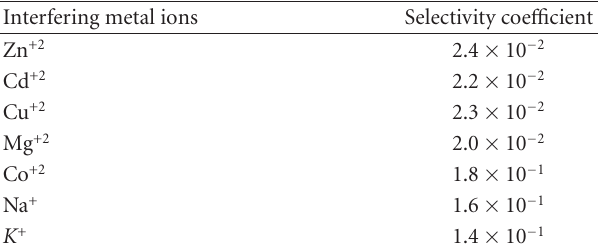
Table 5: Selectivity coe ffi cient of various interfering metal ions of poly-o-anisidine Sn(IV) arsenophosphate composite cation exchanger